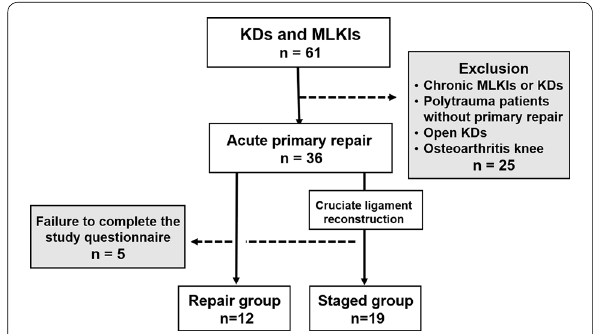
Fig. 1 Flowchart of study. KDs: knee dislocations; MLKIs: multiligament knee